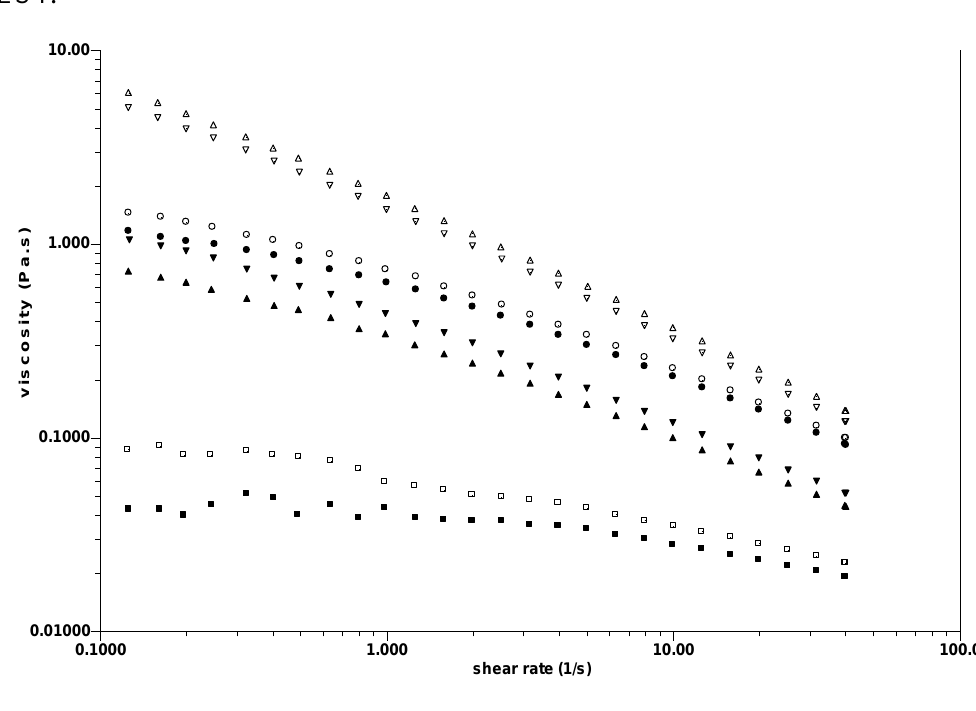
Figure 6. Influence of filtration on rheological behaviour. Open signs for the initial SF; corresponding filled signs correspond to the filtrated samples. ○● LS1; □■ LS2;  ▲ LS3; 